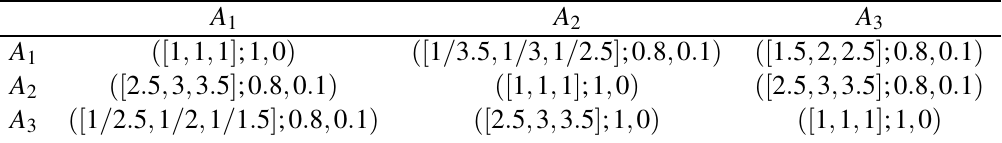
Table 2: Generalized intuitionistic fuzzy pair-wise comparison matrix